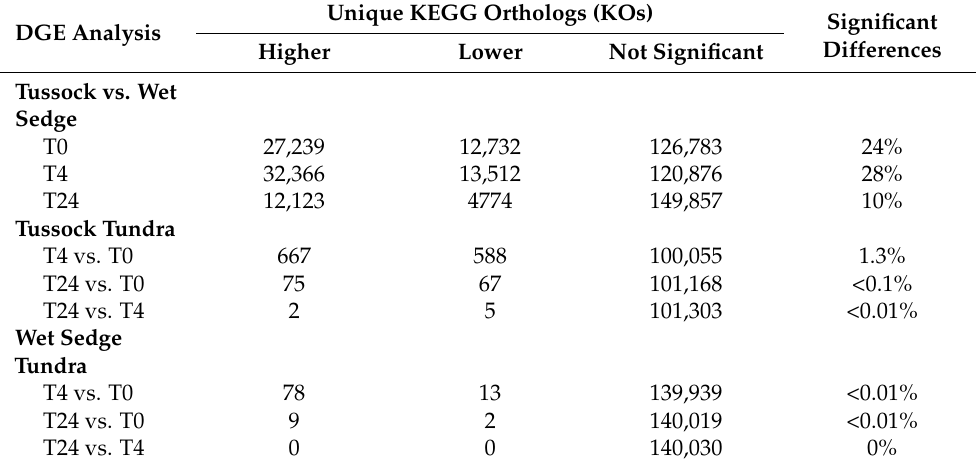
Table 5. Summary of the differential gene expression (DGE) analysis. Values represent counts of KEGG orthologs (KOs; i.e., genes) considered to be differentially expressed if the False Discovery Rate (FDR) was < 0.05. “Higher” or “Lower” differential expression is relative to the first variable in the comparison (e.g., T4 vs. T0 summarizes higher or lower expression in T4 relative to T0). Unique KEGG Orthologs (KOs) Significant DGE Analysis DifferencesHigher Lower Not